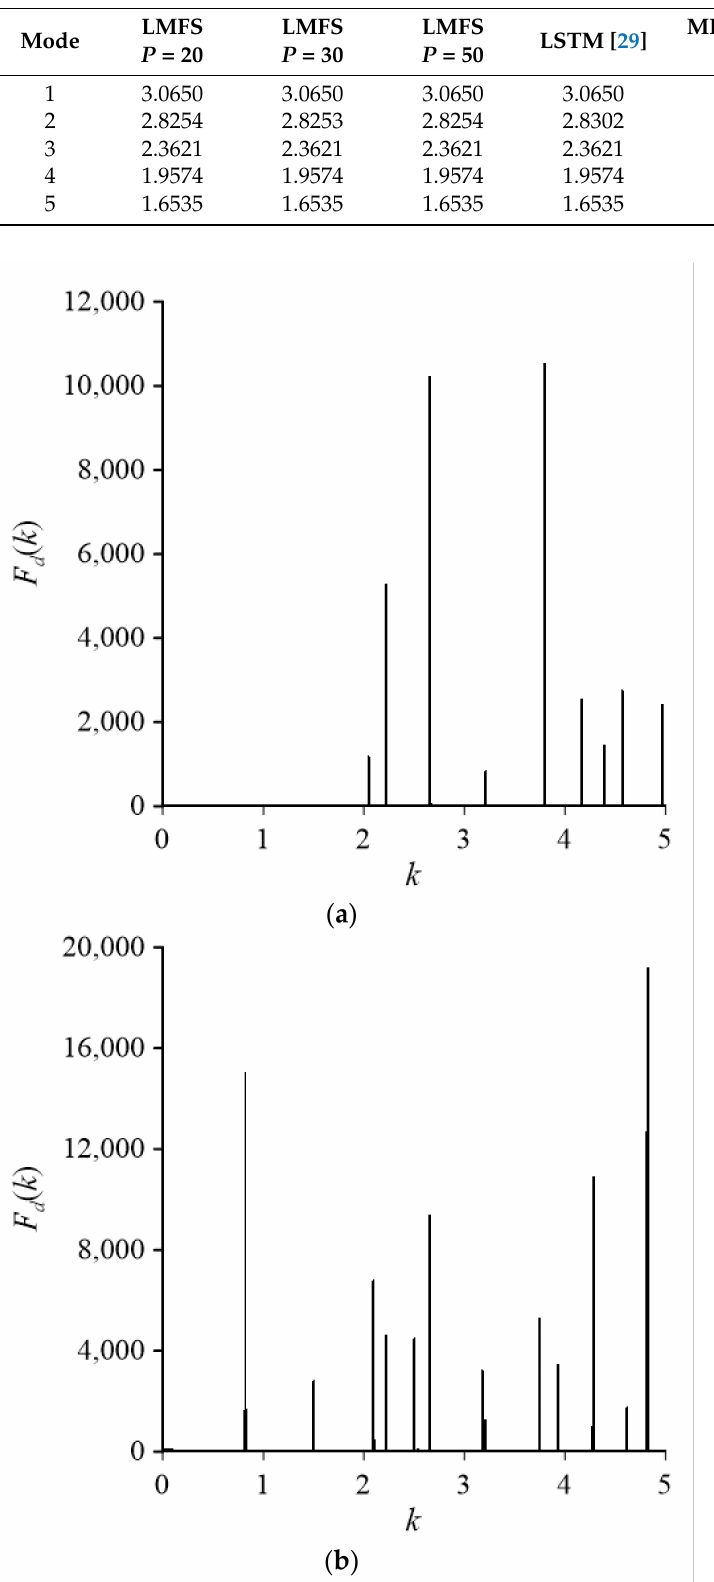
Figure 6. Resonance curves for concentric annular waveguide for ( a ) TM mode and ( b ) TE